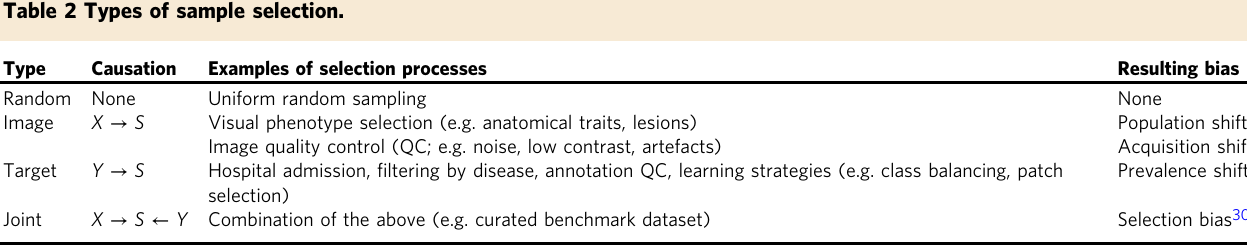
Table 2 Types of sample selection.